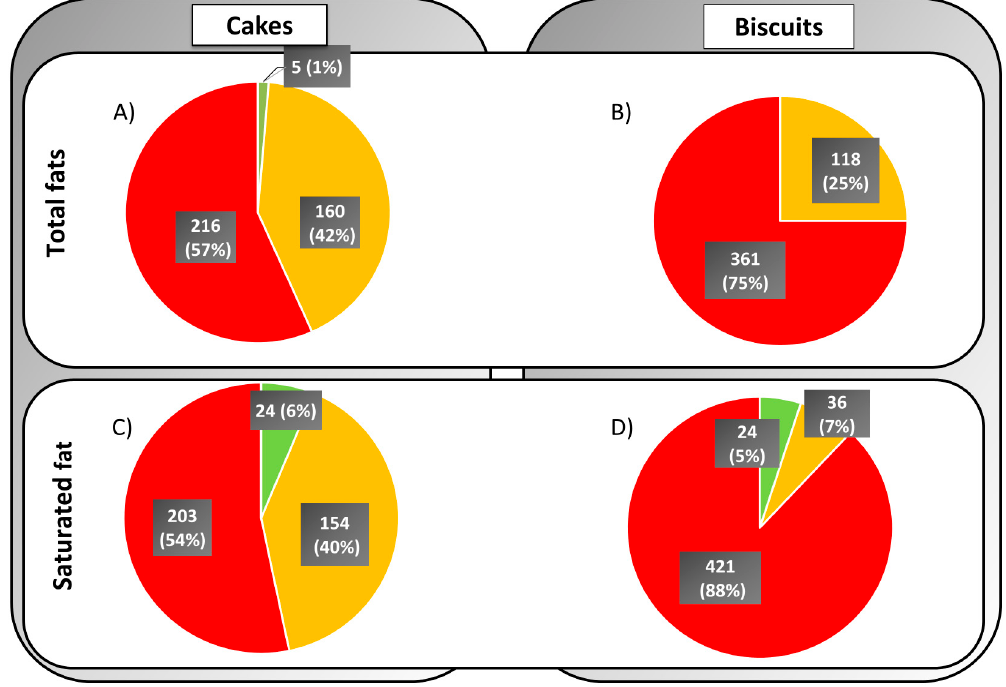
Figure 1. Percentage of cakes ( A and C ) and biscuits ( B and D ) that would receive a low/medium/high criteria for total fat ( A and B ) and saturated fat ( C and D